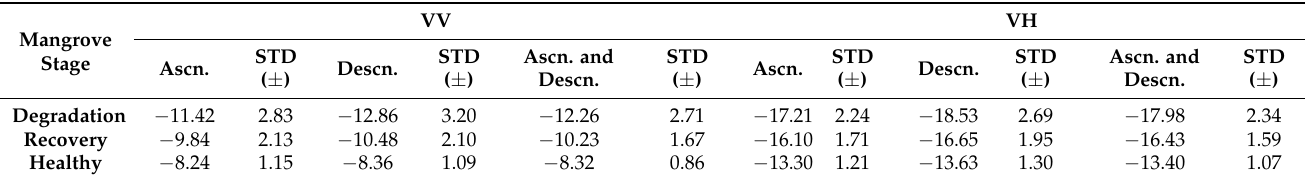
Table 5. The mean and standard deviation of SAR variables for each mangrove